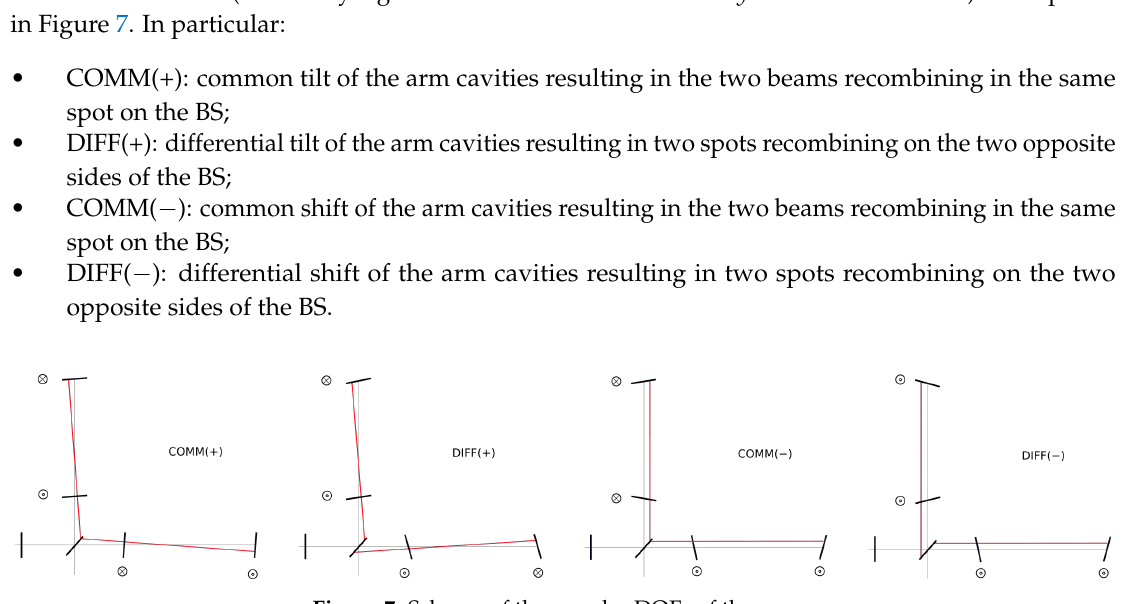
Figure 7. Scheme of the angular DOFs of the